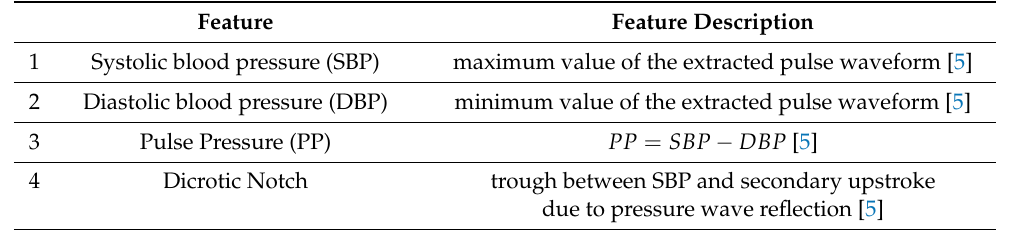
Table 1. Chosen amplitude-based features.